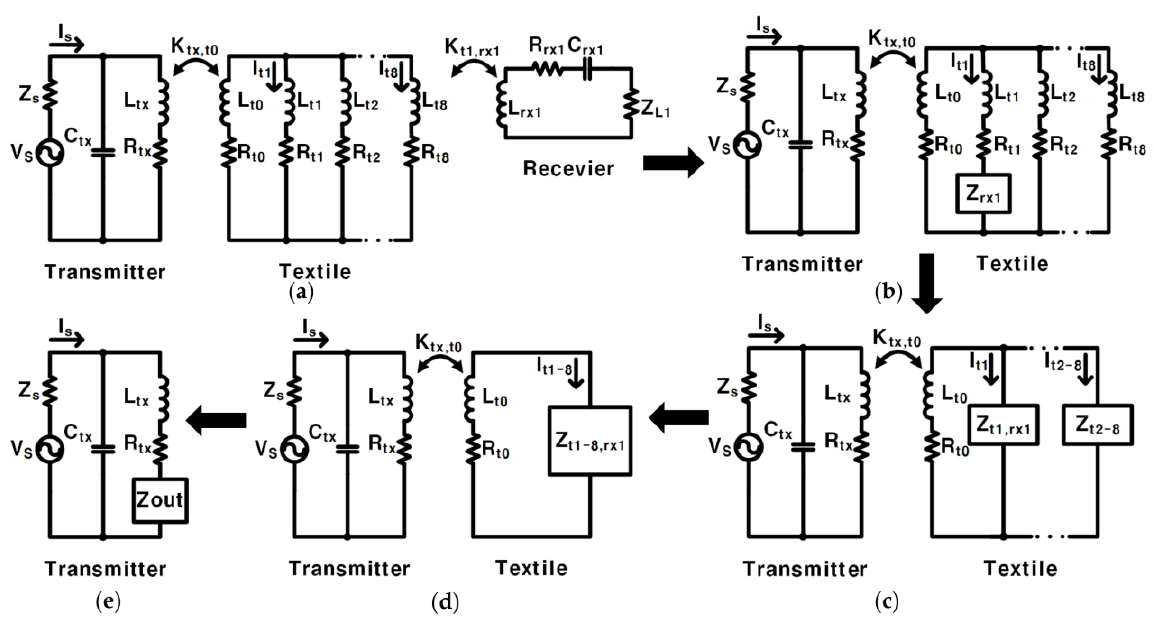
Figure 3. ( a – e ) are equivalent circuits.